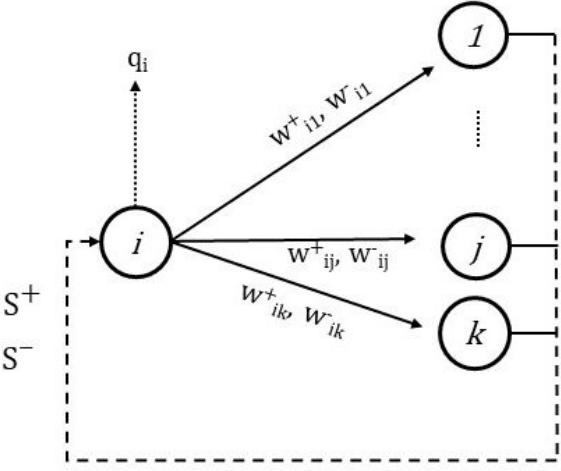
Figure 3. An RNN neuron and its